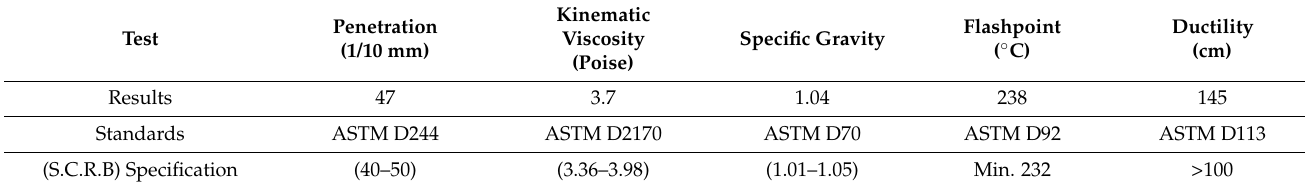
Table 1. Mechanical properties of the used (40–50) binder.